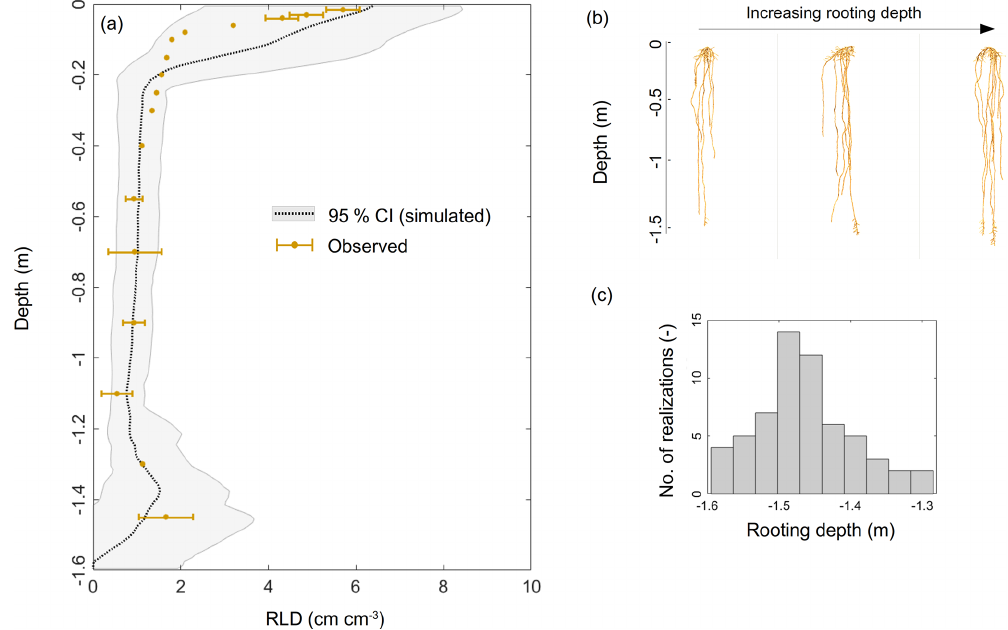
Figure 1. (a) Simulated (gray shading) and observed (brown dots) root length density profiles. Panels (b) and (c) illustrate the variability in the modeled root system architectures and rooting depths,